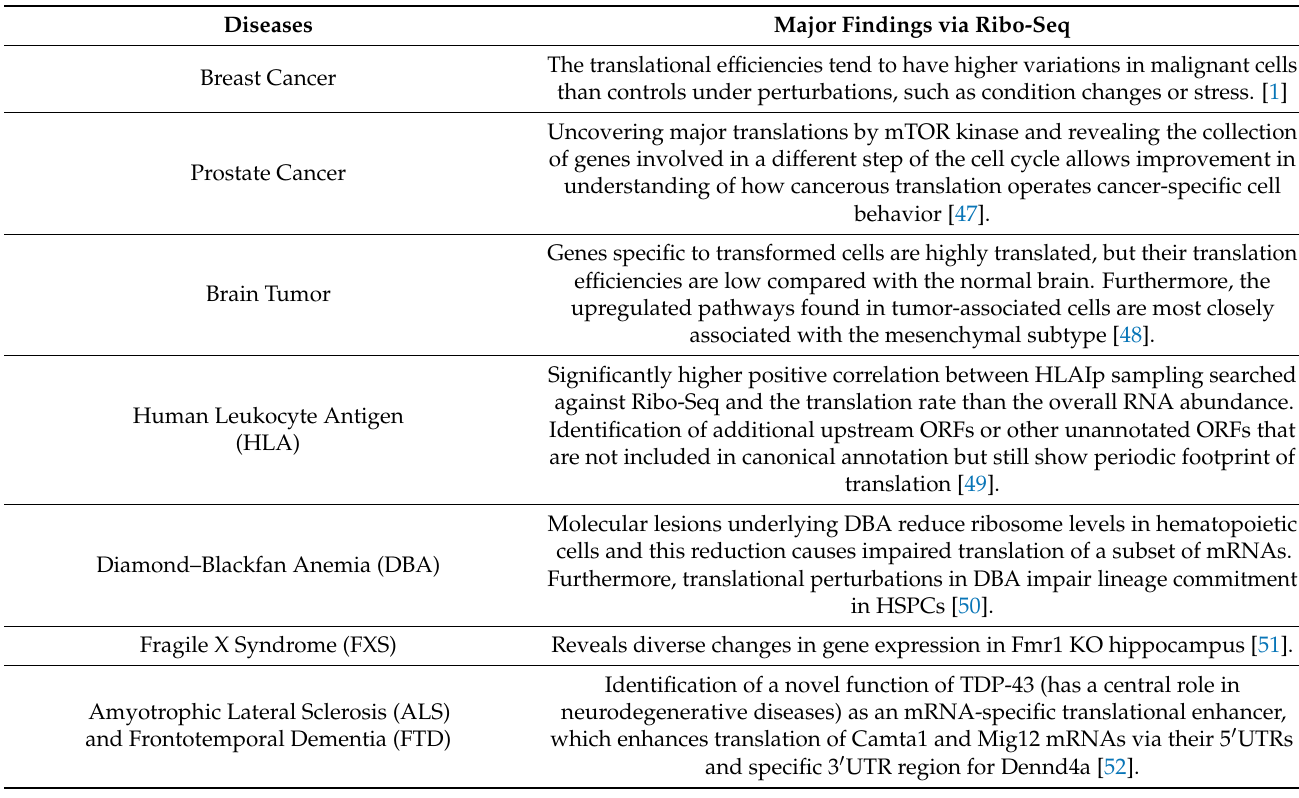
Table 2. Ribo-seq identifies human disease mechanisms at the translational